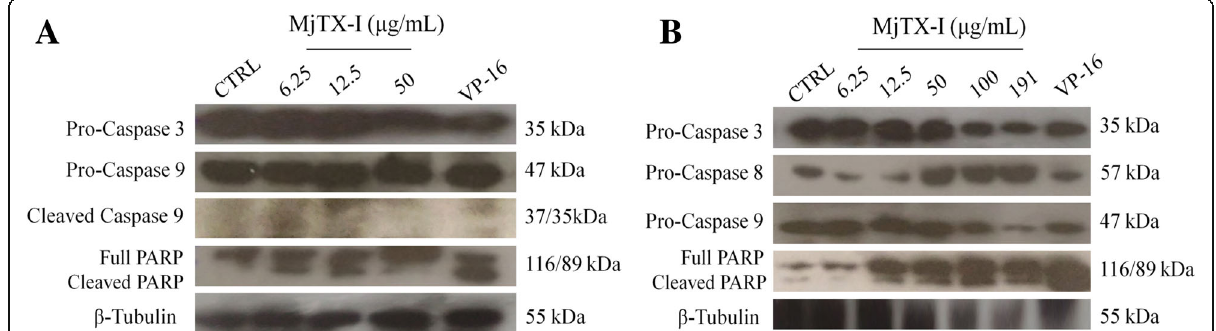
Fig. 4 Western blotting analysis of protein expression in ( a ) K562-S and ( b ) K562-R cells treated with MjTX-I. Detection of expression of caspases 3, 8, and 9 and PARP after a 24-h treatment with MjTX-I. CTRL: untreated cells (negative control). VP16: etoposide (positive